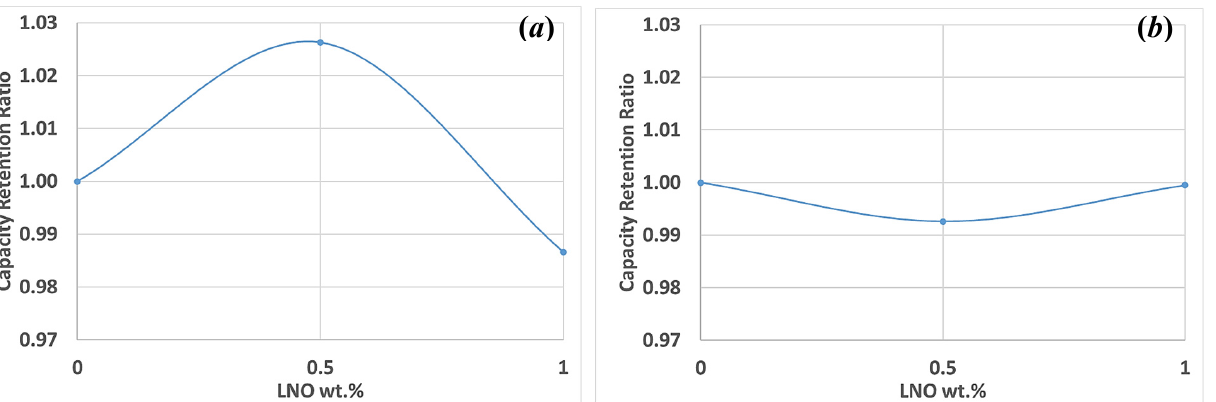
C-rates of C/10, C/5, C/3, C/2, C, and 2C followed by a return to C/10 were